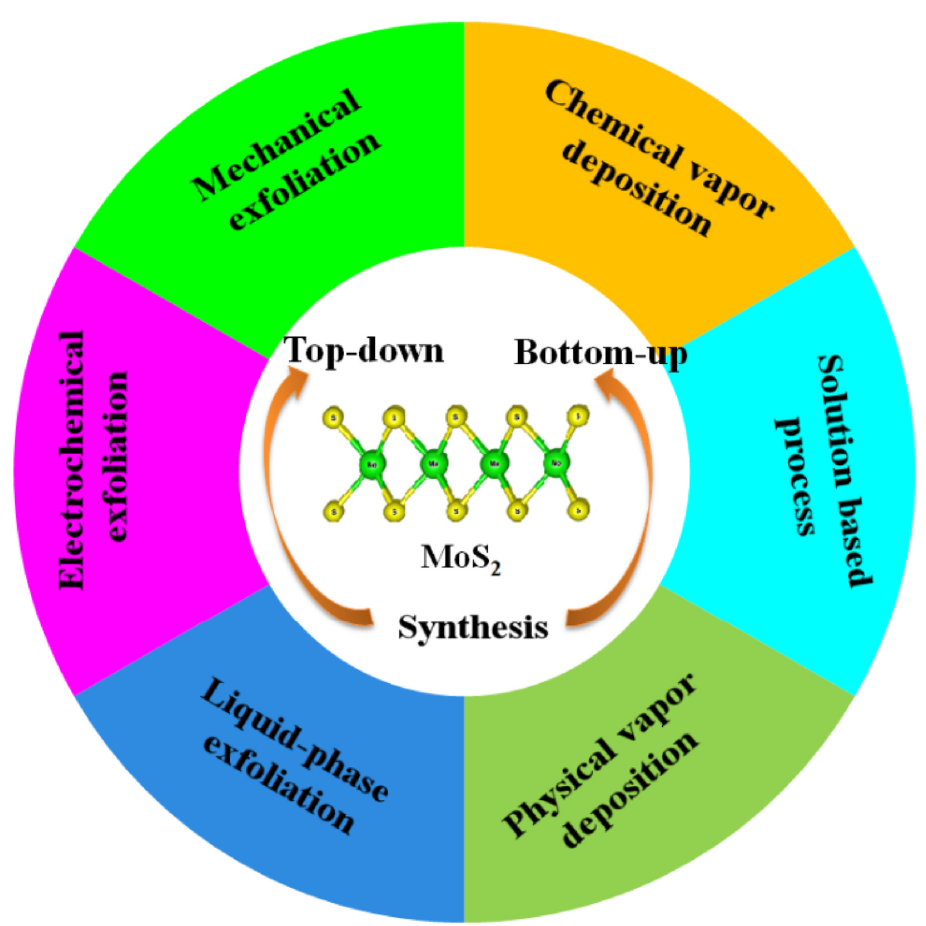
Figure 8. Various synthetic methods for MoS 2 preparation. Reprinted with permission for Ref. [74]. Copyright 2022 MDPI.